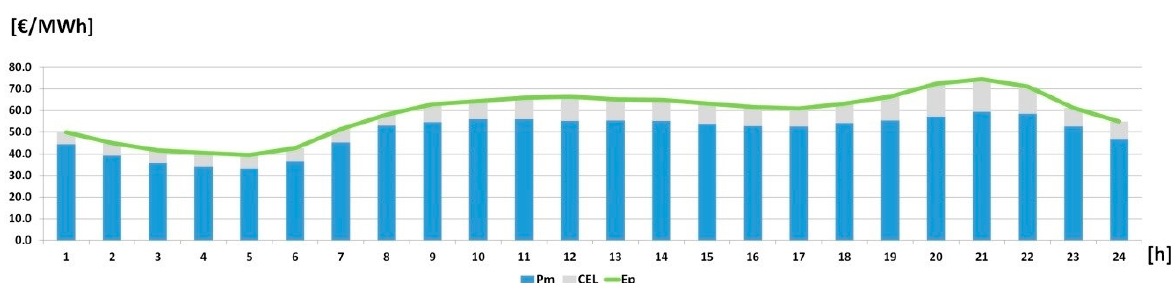
Figure 10. Equivalent electricity price (in green color) of the consumer for a simulation day (autumn weekday). Source: self-elaboration.